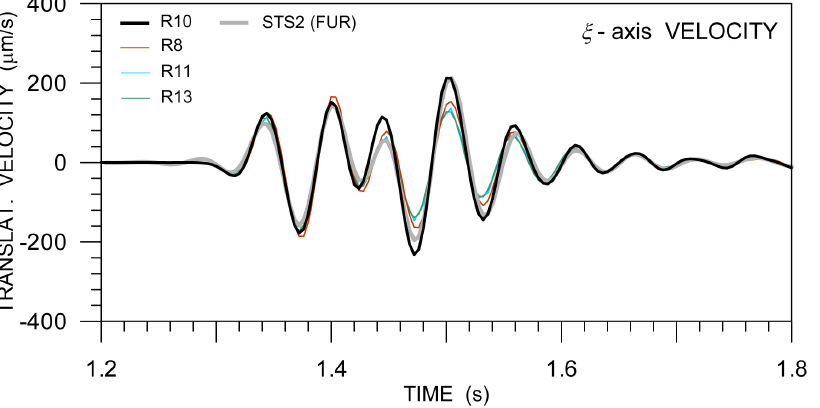
Figure 14. Radial ground velocity component v ξ from FUR, resampled to 250 Hz (gray) and from R10 (black). Records from R8 (red), R11 (light blue) and R13 (green), placed next to the concrete block, are shown for comparison. All of the records are filtered in the same way and